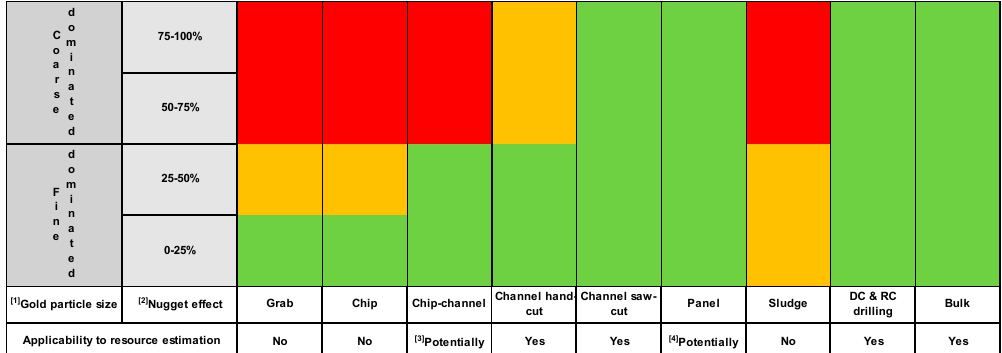
Figure 10. Generalised applicability of sampling methods based on mineralisation type (dominance of coarse vs. fine gold and nugget effect). Red: avoid method; Orange: avoid method where possible; Green: method applicable, assuming good practices, optimised protocols, and QAQC. [1] Coarse nominally defined as gold >100 µm in size; [2] Nugget effect sub-divided into four ranges: low (0–25%), medium (25–50%), high (50–75%) and extreme (75–100%); [3] Chip-channel samples potentially appropriate